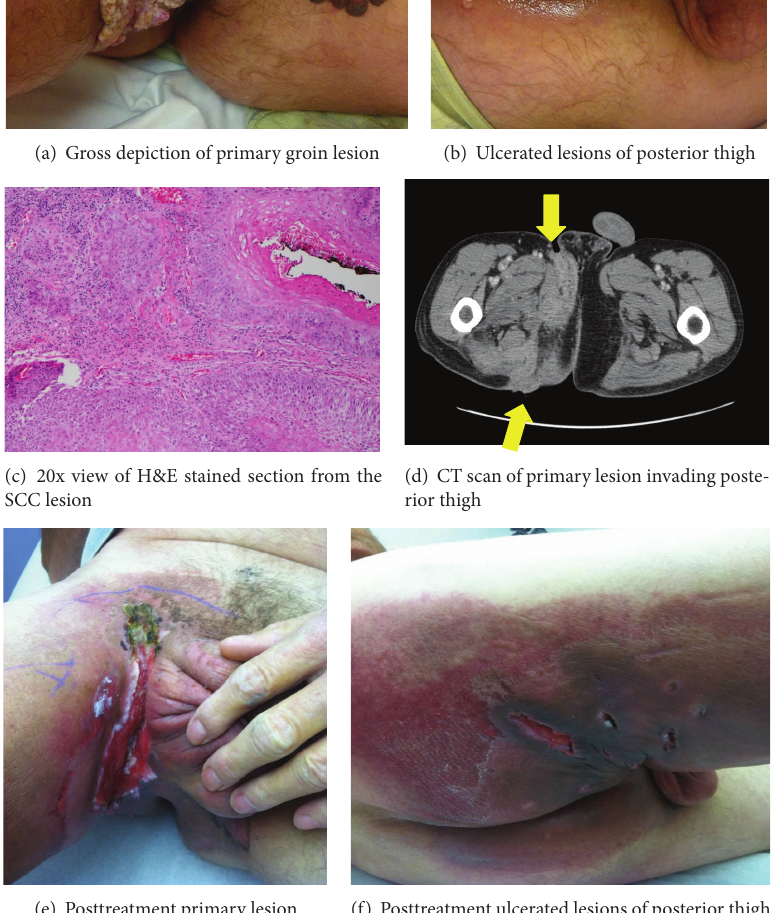
Figure 1: (a) Gross depiction of primary groin lesion. (b) Ulcerated lesions of posterior thigh. (c) 20x view of H&E stained section from the SCC lesion. (d) CT scan of primary lesion invading posterior thigh. (e) Posttreatment primary lesion. (f) Posttreatment ulcerated lesions of posterior